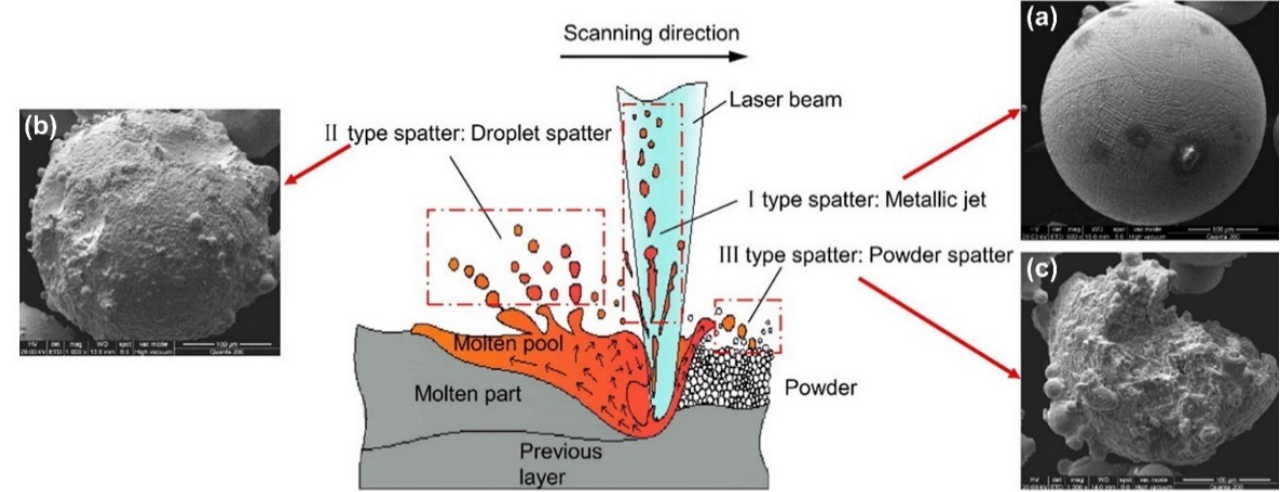
Figure 8. Formation mechanisms of different types of spatter during L-PBF: ( a ) morphology of spherical spatter (Type-I spatter); ( b ) morphology of coarse spherical morphology (Type-II spatter); ( c ) morphology of irregular spatter (Type-III spatter). (Reprinted with permission from Ref. [63]. Copyright 2016 Elsevier B.V.).